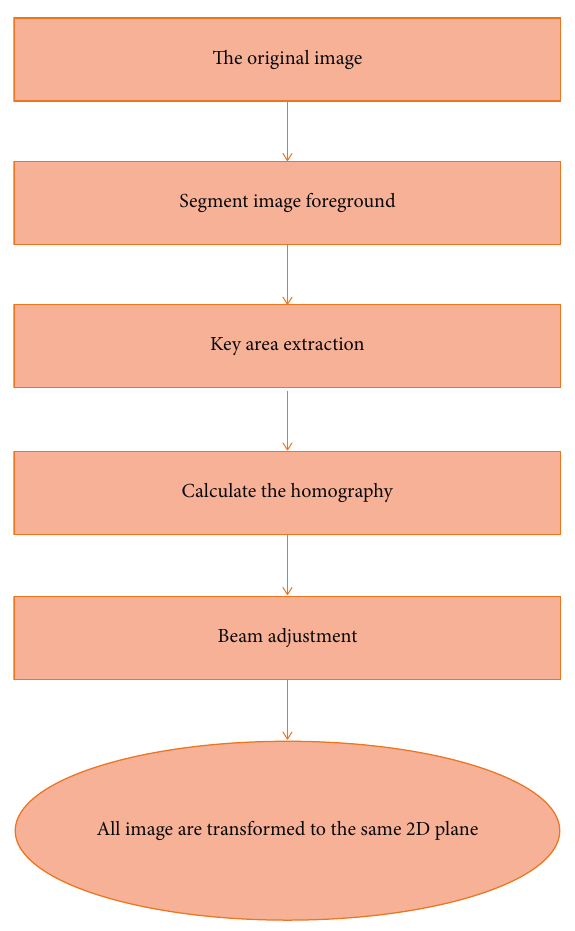
Figure 5: Stereo image 2Dization